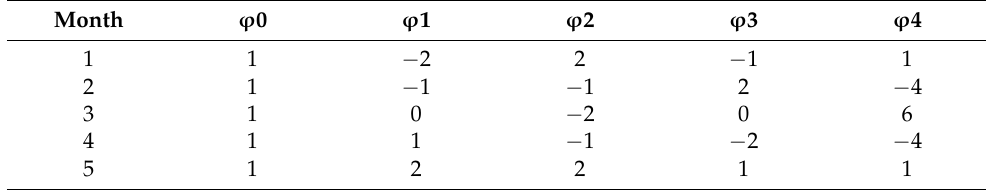
Table 6. Chebyshev orthogonal n =